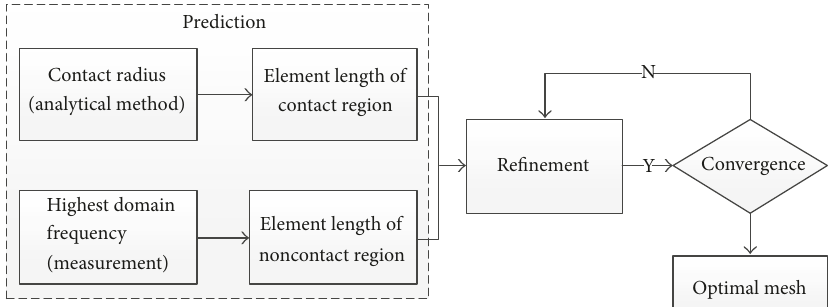
Figure 10: The “Prediction-Refinement” discretization strategy for impact dynamics.